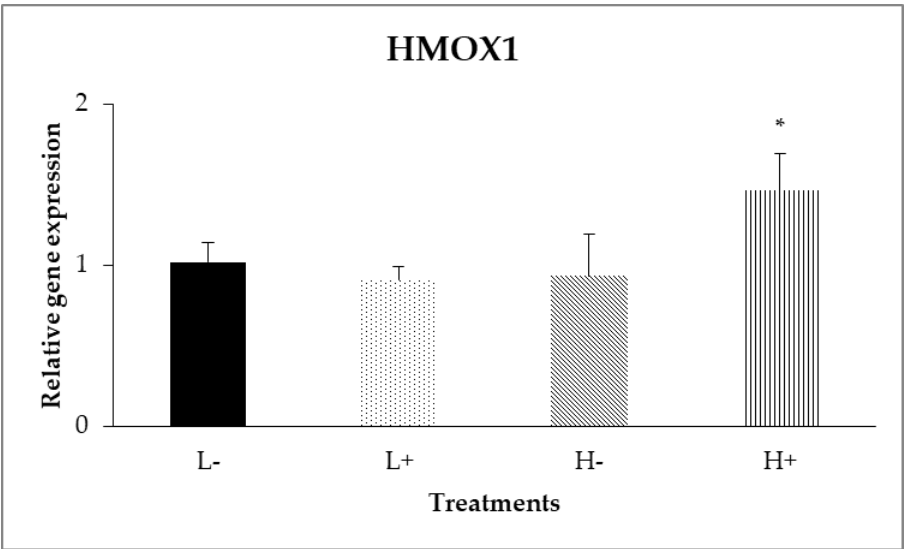
Figure 3. Interaction effects of diet type and phytogenic feed additive (PFA) supplementation on relative gene expression of HMOX1 in ileal mucosa of 42-day-old broilers. Columns indicate treatments means + SD, and the asterisk denotes statistical difference ( P D×P = 0.024).